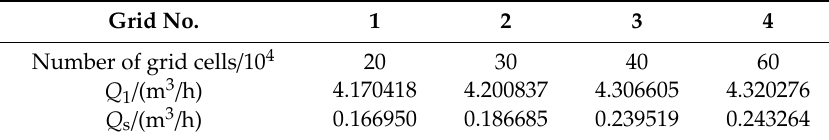
Table 2. Grid independence test of the venturi injector under the flow conditions of P 1 = 350 kPa and P 2 = 100 kPa.